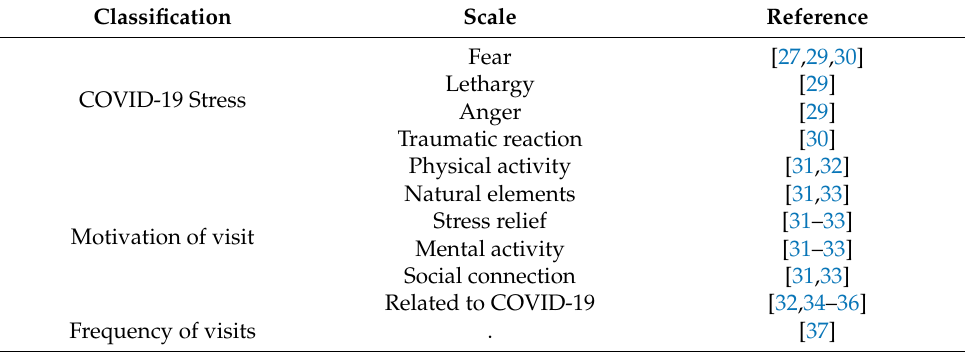
Table 1. Scale and references for